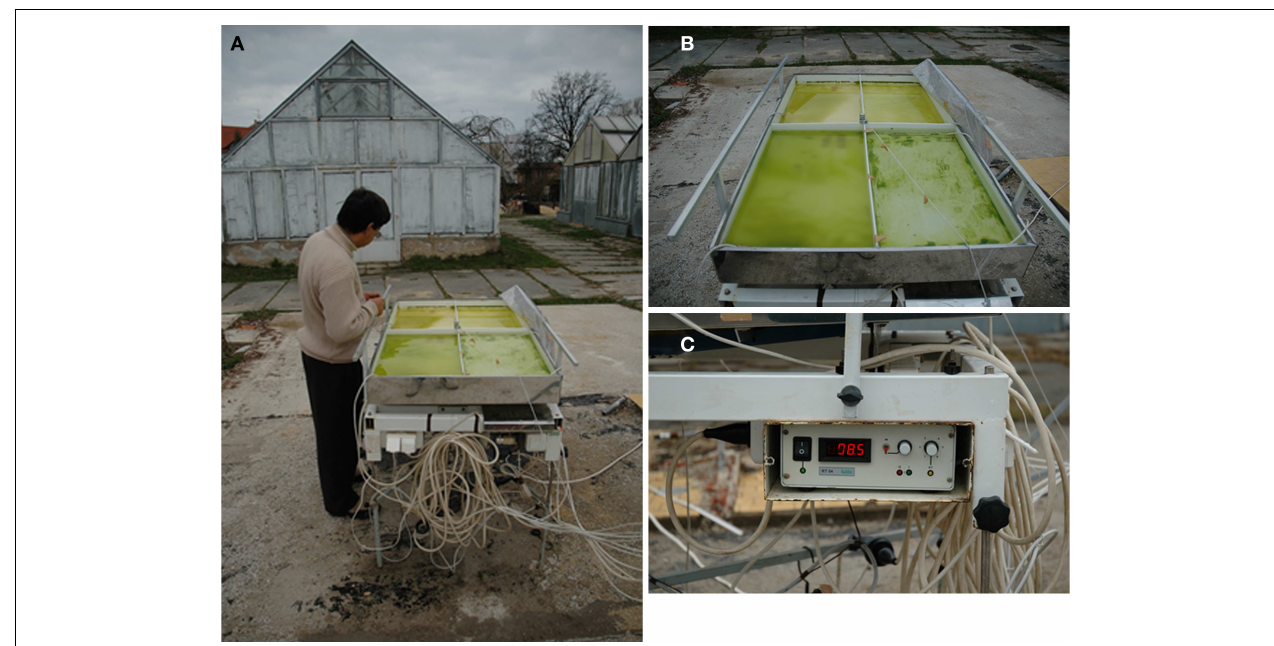
FIGURE 1 |The out-door micro-scale mass cultivation experiment . (A) The cultivation unit (Labio, Czech Republic), (B) detailed view of the cultivation well with micro-algal culture, (C) detailed view of the thermoregulation control